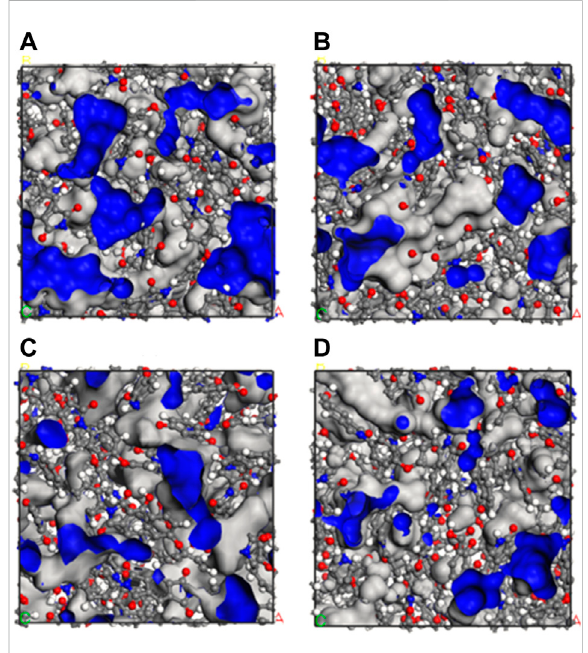
FIGURE 11 (A – D) are free volume diagrams of polyimide models. The difference is that (A) represents free volume diagrams of ordinary polyimide, (B) represents free volume diagrams of 10% plasma modi fi ed polyimide, (C) represents free volume diagrams of 20% plasma modi fi ed polyimide, and (D) represents free volume diagrams of 30% plasma modi fi ed polyimide, which have been mentioned in the paper, The title can serve as an overview.